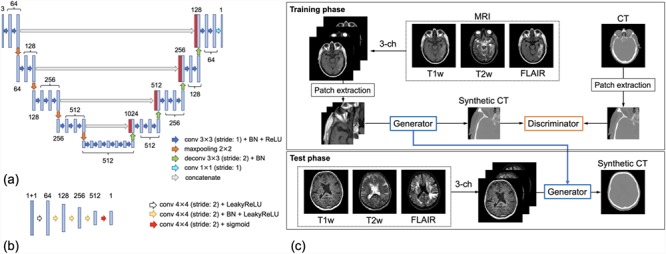
Schematic representation of the proposed method to generate sCT images. (a) The architecture of the generator and (b) discriminator. (c) Overview of the cGAN-based method to generate sCT images from multiple MR sequences. BN = batch normalization; conv = convolutional layer; deconv = deconvolutional layer; LeakyReLU = leaky rectified linear units; ReLU = rectified linear units; sigmoid = sigmoid activation function.